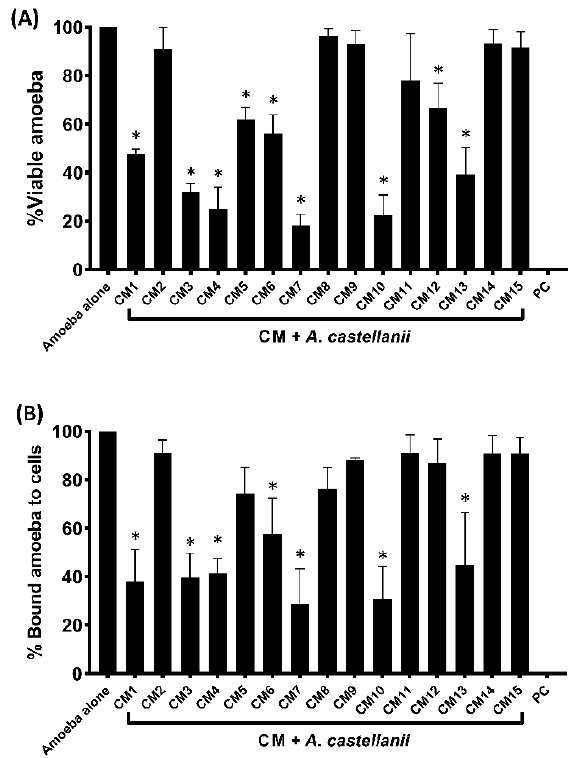
Figure 2. (A ) Conditioned media were prepared by incubating each bacterium in RPMI at 37 °C for 48 h. Next, bacterial cultures were centrifuged for 60 min at 10,000 × g at 4 ◦ C, and supernatants, i.e., CM, were filtered using 0.22 µ m pore size filters. Equal doses (100 µ L) of various bacterial CM were used to determine amoebic effects. Briefly, A. castellanii , i.e., 5 × 10 5 , were incubated with 100 µ L of CM for 24 h at 30 ◦ C. After this, viable amoebae were counted using a hemocytometer microscopically. Amoebae grown in RPMI alone were taken as the negative control, while amoebae incubated with 25 µ M chlorhexidine were used as the positive control. The data are expressed as the mean ± standard error. p values were determined using two-sample t -test, two-tailed distribution, and (*) is p ≤ 0.05. p ≤ 0.05 was chosen as the statistical significance threshold. ( B ) Conditioned media from water monitor lizard gut bacteria repressed the A. castellanii binding to human cells. Adhesion assays were performed to determine whether A. castellanii interacts with human cells. Note that CM repressed A. castellanii significantly. p values were determined using two-sample t -test, two-tailed distribution, (*) is <0.05. The data are expressed as the mean ± standard